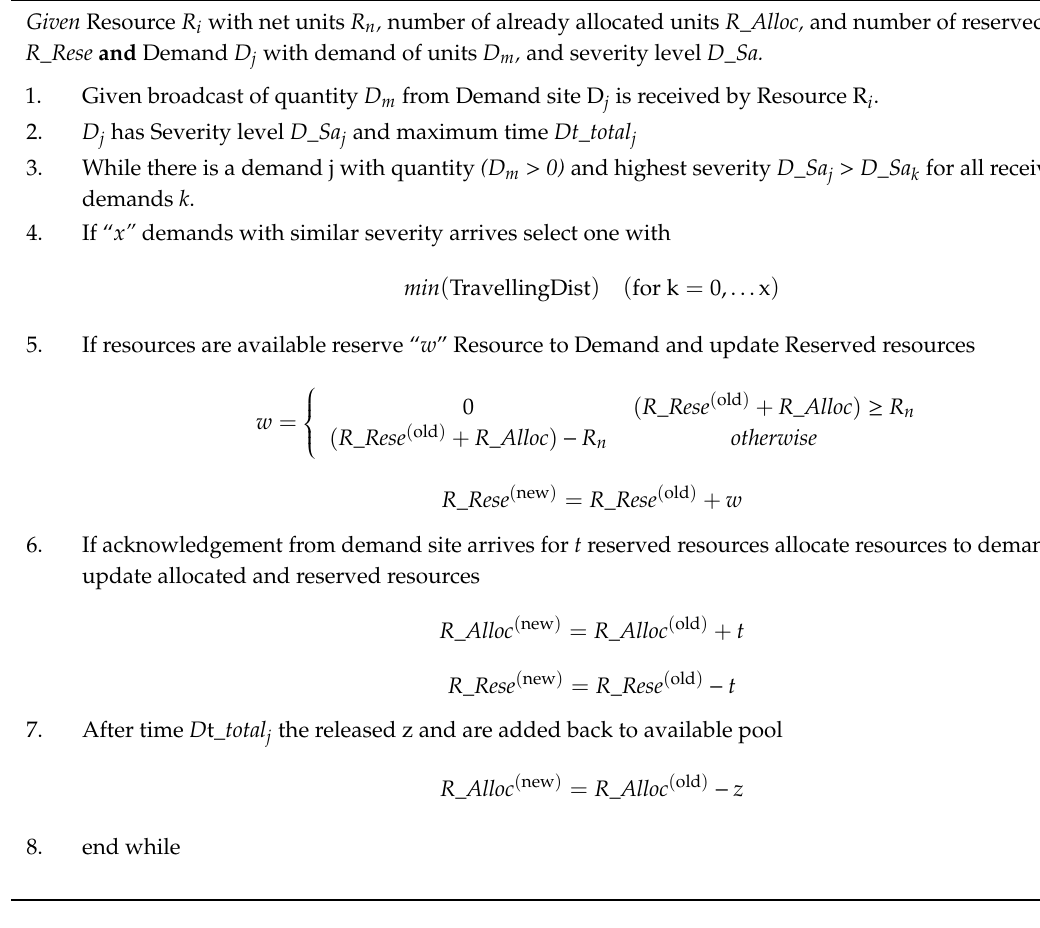
Algorithm I: HSL